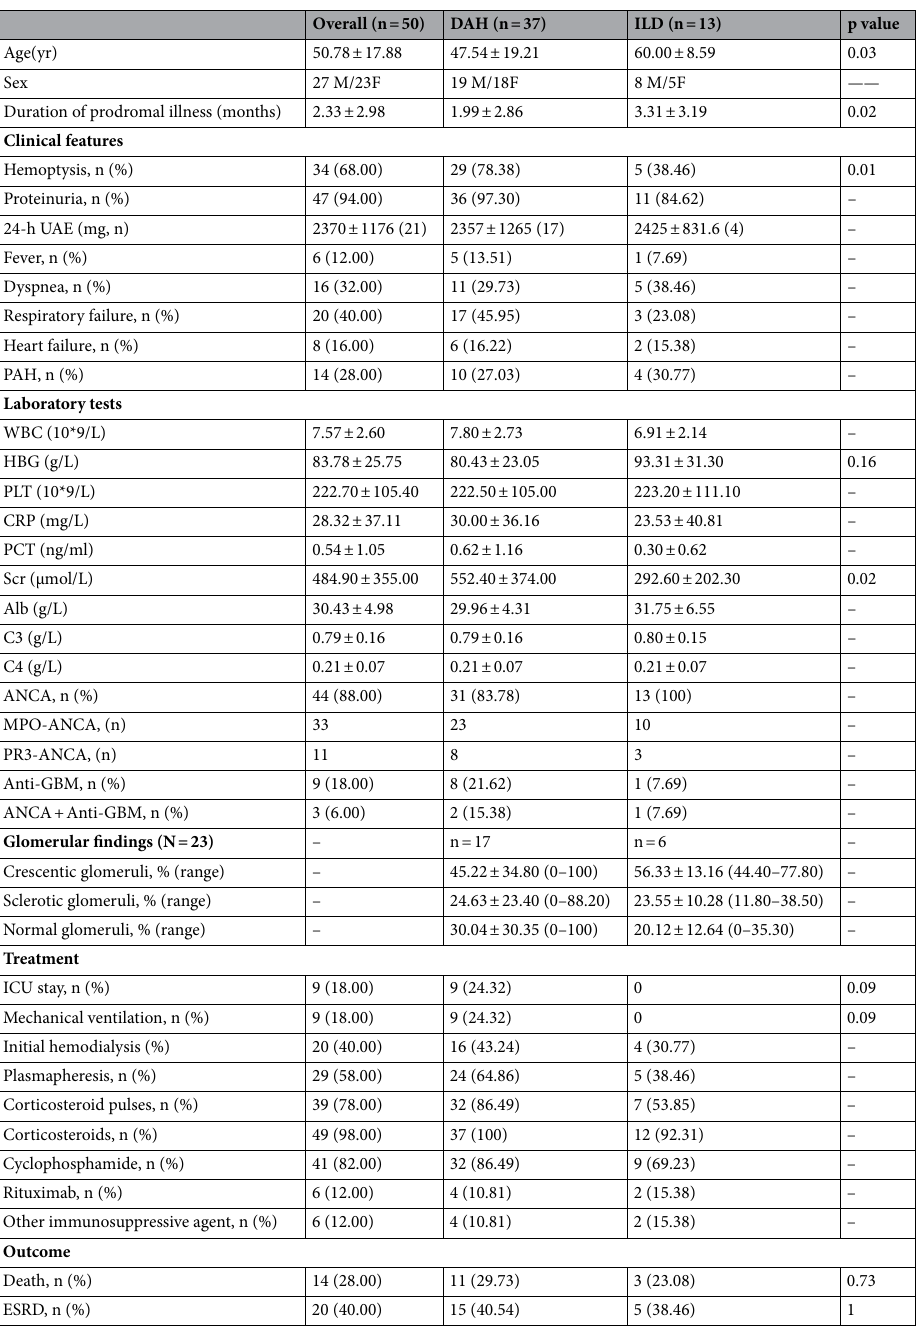
Table 1. Characteristics of the included 50 PRS patients. M male, F female, HBG hemoglobin, WBC white blood cell, CRP C reactive protein, PCT procalcitonin, GM galactomannan, G test (1,3)-β-D glucan test, T-spot tuberculosis-specific enzyme-linked immunospot assay, C3 complement 3, C4 complement 4, MPO myeloperoxidase, PR3 proteinase 3, ICU intensive care